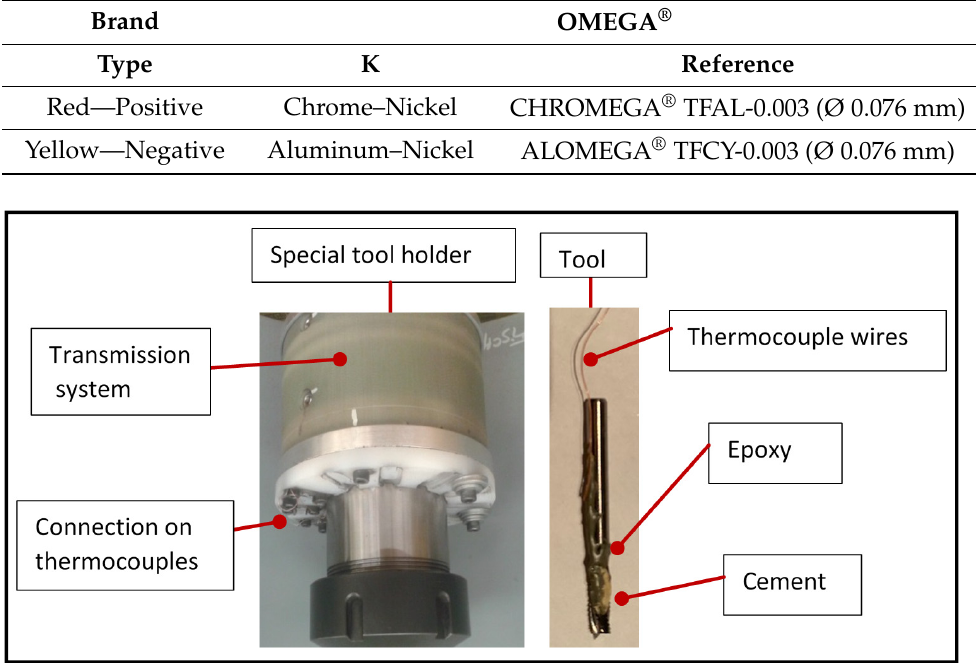
Table 4. Machining parameters and selected levels. Factors